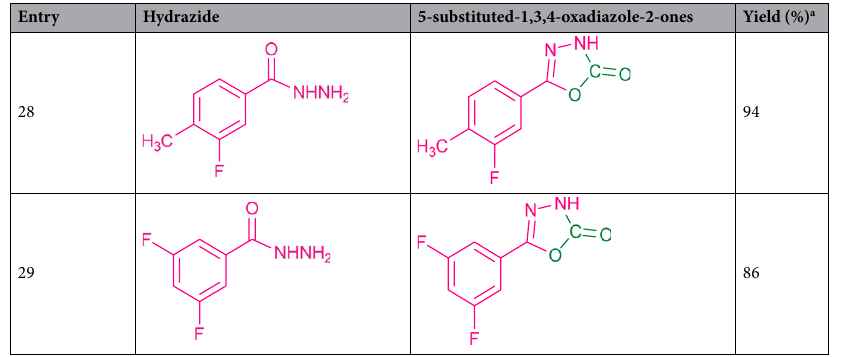
Table 2. Ultrasound-assisted direct cyclization of various hydrazides to 5-substituted-3H-[1, 3, 4]-oxadiazole- 2-ones (SOxdOs) using rGOPhSO 3 H nano catalyst. a Isolated product.